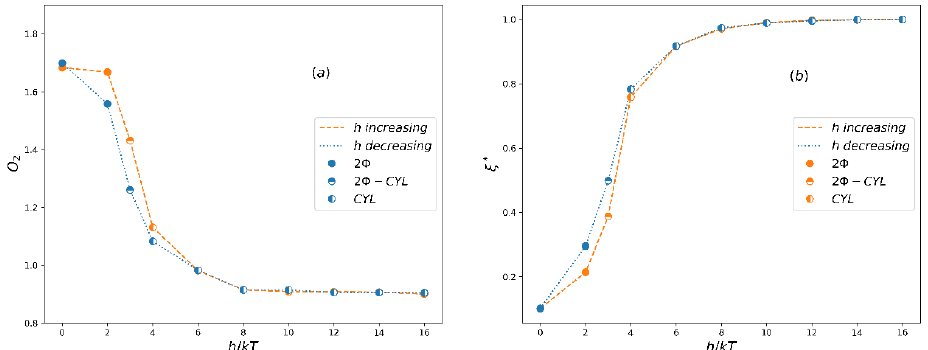
Figure 6. ( a ) The averaged order parameter, O 2 , and ( b ) the normalized extent of reaction, ξ ∗ , as a function of the reversible bond strength, h , for system A3B7. CYL denotes a cylindrical phase, 2 Φ -CYL denotes a coexistent phase and 2 Φ denotes a two-phase state.